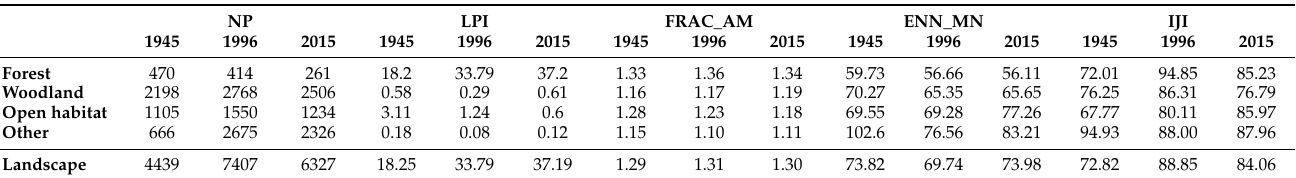
Table 3. Landscape metrics calculated for all the studied years and per LULC class, as well as at the landscape level. NP: Number of patches, LPI: Largest Patch Index, FRAC_AM: Area-Weighted Mean of Fractal Dimension Index, ENN_MN: Mean of Euclidean Nearest Neighbor Distance, IJI: Interspersion Juxtaposition